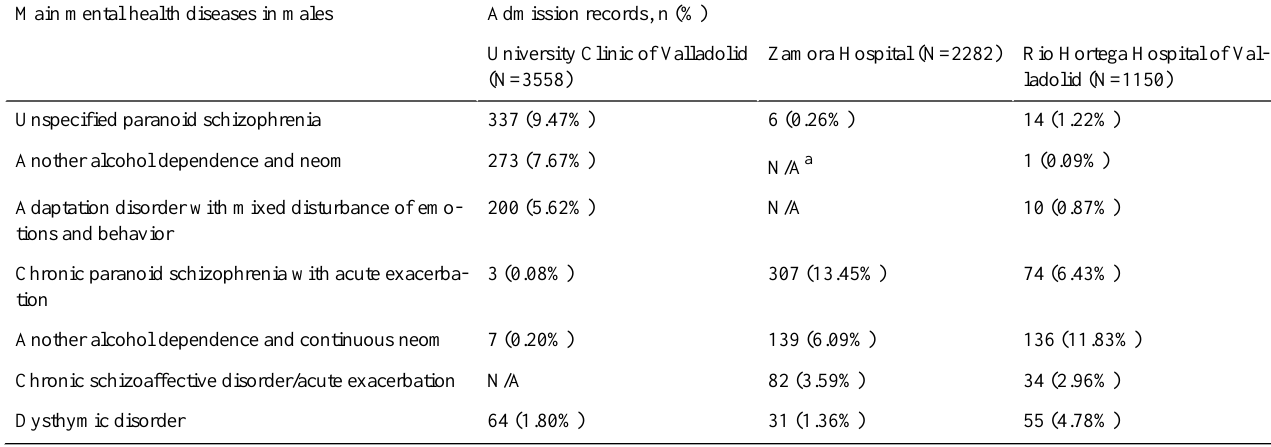
Table 2. Admission records according to mental health diseases in males for health care complexes in Valladolid and